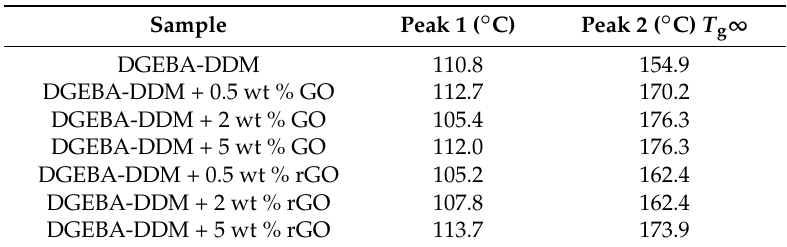
Table 4. Glass transition temperatures of neat epoxy system and composites with 0.5, 2, and 5 wt % of GO and rGO cured at a temperature of 90 °C.